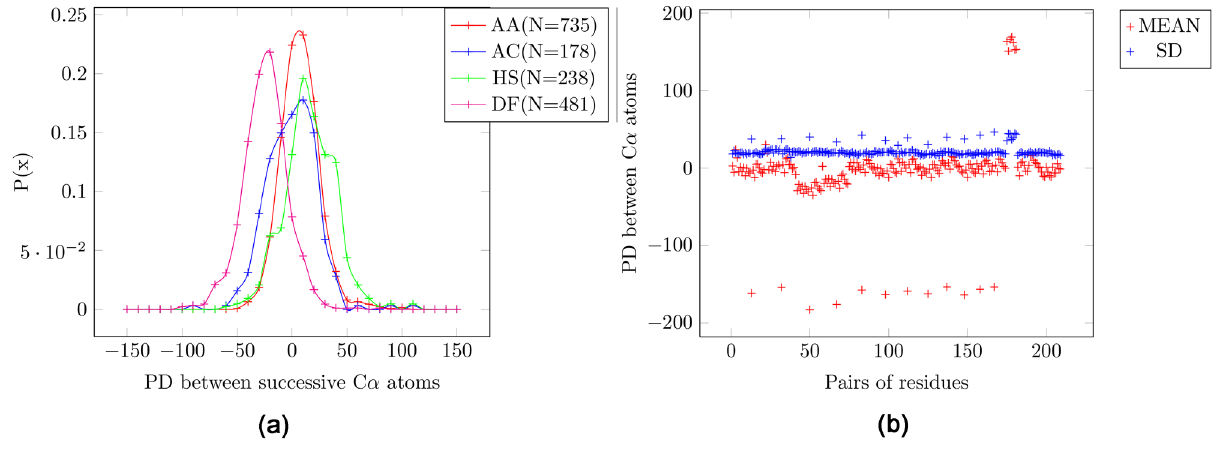
Figure 2. Electrostatic potential differences (PD) for consecutive residue pairs for C α atoms. A: Alanine/Alanine, AC: Alanine/Cysteine, HS: Histidine/Serine, DF: Aspartic-acid/Phenylalanine. ( a ) Probability distribution for four pairs of amino acids. ( b ) Scatter plot for all pairs of amino acids. It is seen that pairs of amino acids which include proline have a higher mean, although the magnitude of SD is the same.